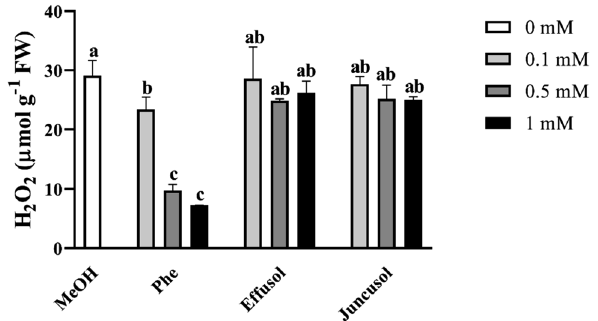
Figure 8. H 2 O 2 contents of seedlings treated with Phe, effusol and juncusol at different concentrations compared to MeOH. Data are presented as the mean ± SE (n = 3). Different letters indicate significant differences between the values of the treatments (P < 0.05) analysed by Tukey’s post-hoc test.